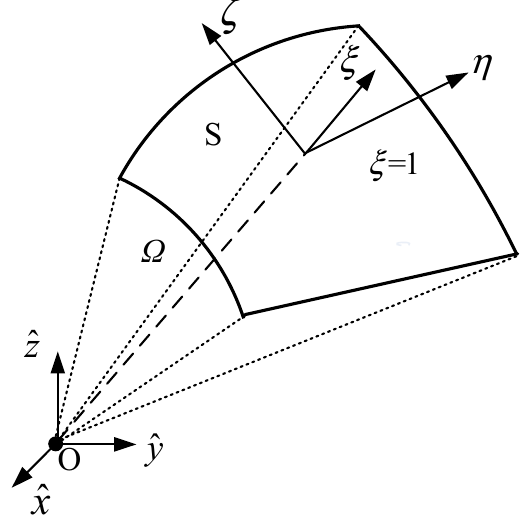
Figure 2. Sketch of the scaled boundary coordinate system.